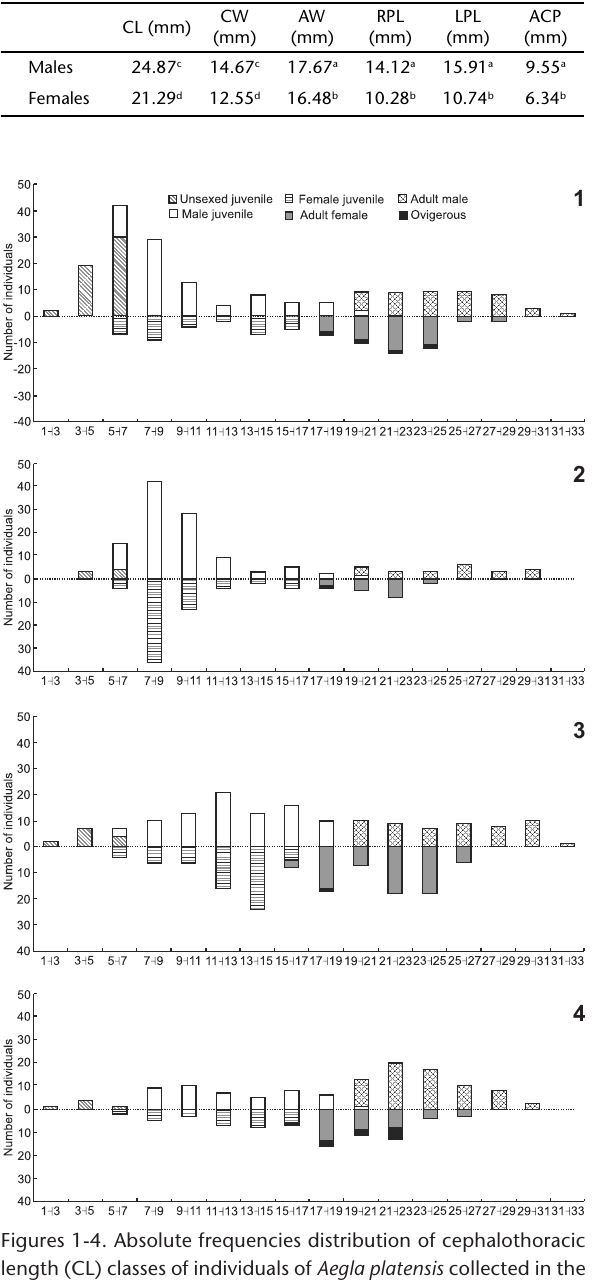
Figures 1-4. Absolute frequencies distribution of cephalothoracic length (CL) classes of individuals of Aegla platensis collected in the Lajeado Bonito stream, Uruguay Basin, Rio Grande do Sul state. Different letters indicate seasons: (1) spring; (2) summer; (3) au- tumn and (4) winter.